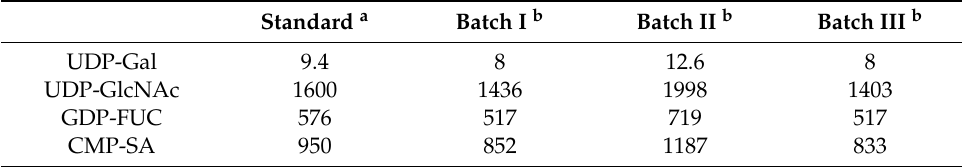
Table 3. Input value setting for nucleotide sugars ( µ